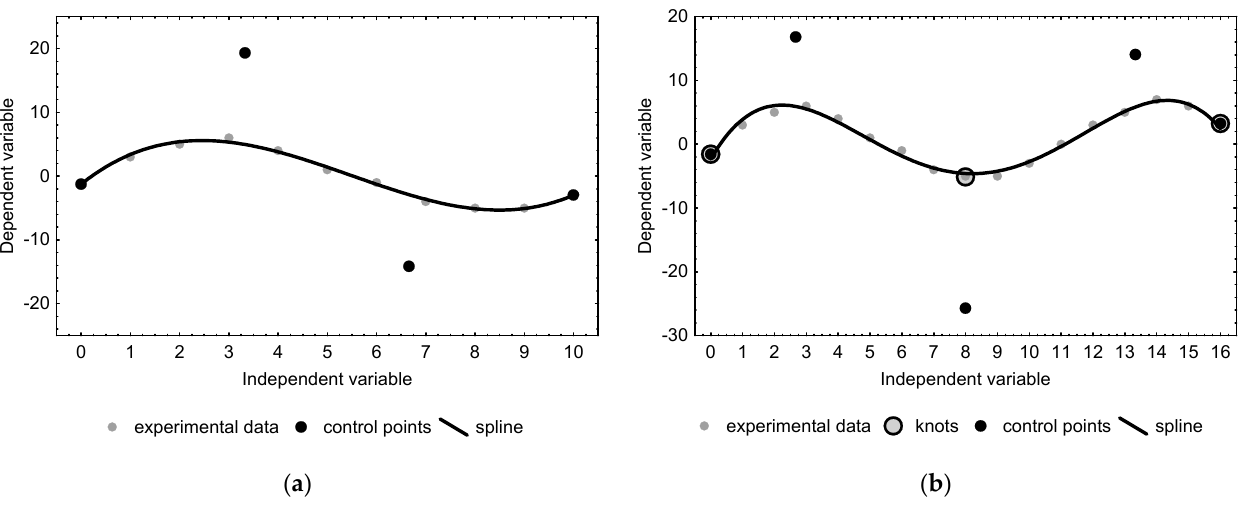
Figure 2. Diagrams showing the distribution of knots and control points when approximating data using the B-spline method for ( a ) a single polynomial reflecting a data set with a run close to the third-order polynomial (4 auxiliary points), and ( b ) a B-spline consisting of two polynomials reflecting a data set with a run close to the fourth order polynomial (5 control points).